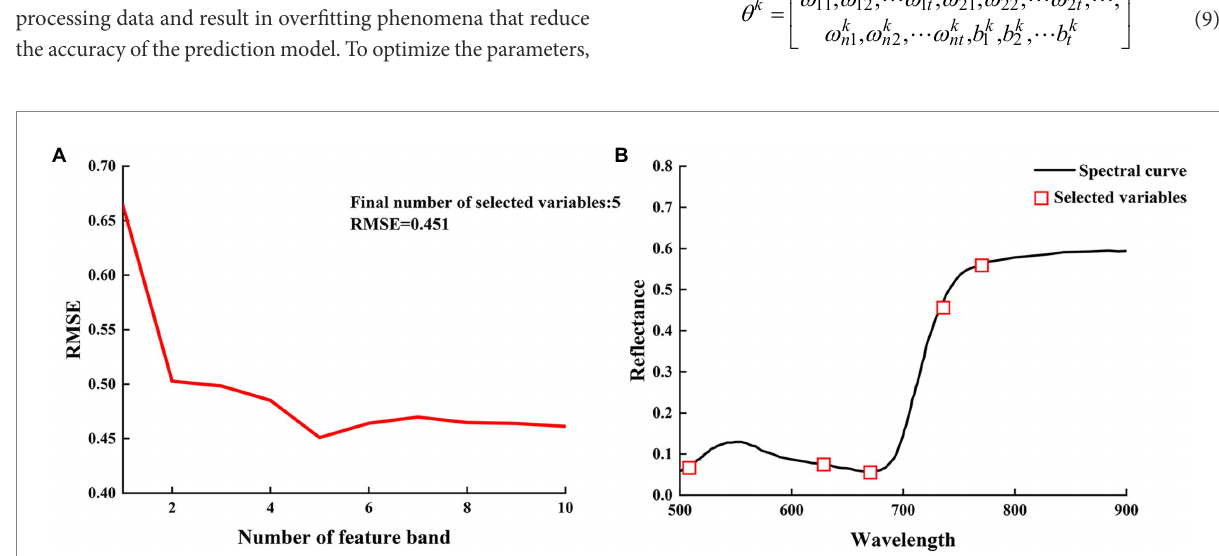
FIGURE 7 (A) Number of the best spectral variable for sample model; (B) Selection of characteristic hyperspectral